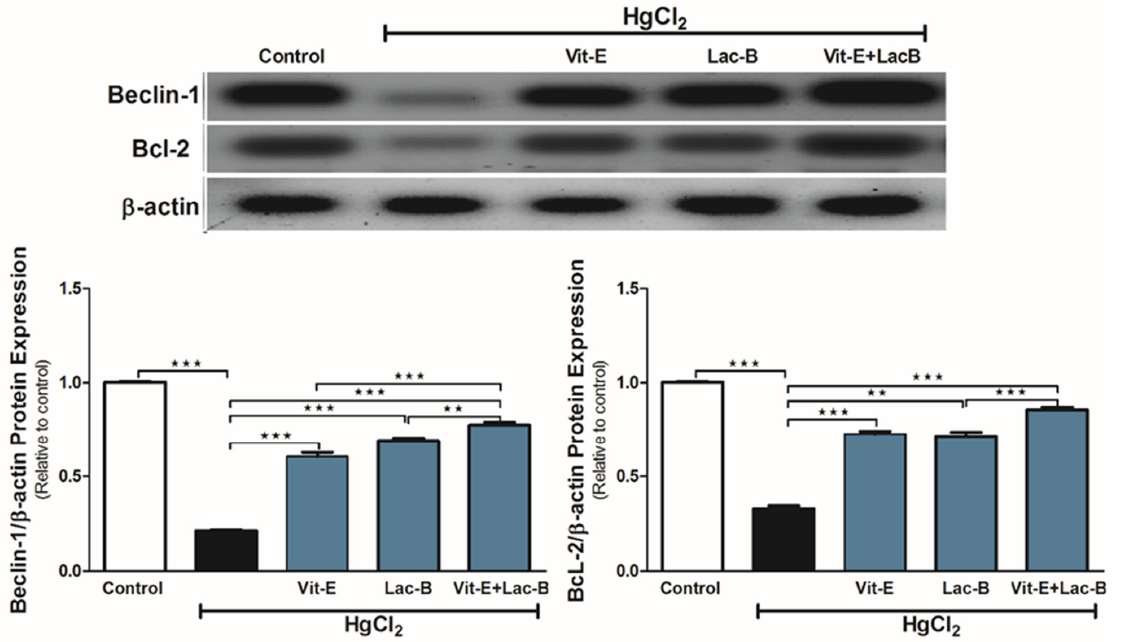
Figure 3. Vit-E and Lac-B upregulated renal Beclin-1 and Bcl-2 expression in HgCl 2 -intoxicated rats. Representative blots show changes in the expression of Bcl-2 and Beclin-1 in all treated groups. Data were expressed as mean ± SEM, ( n = 6). ** p < 0.01 and *** p < 0.001.